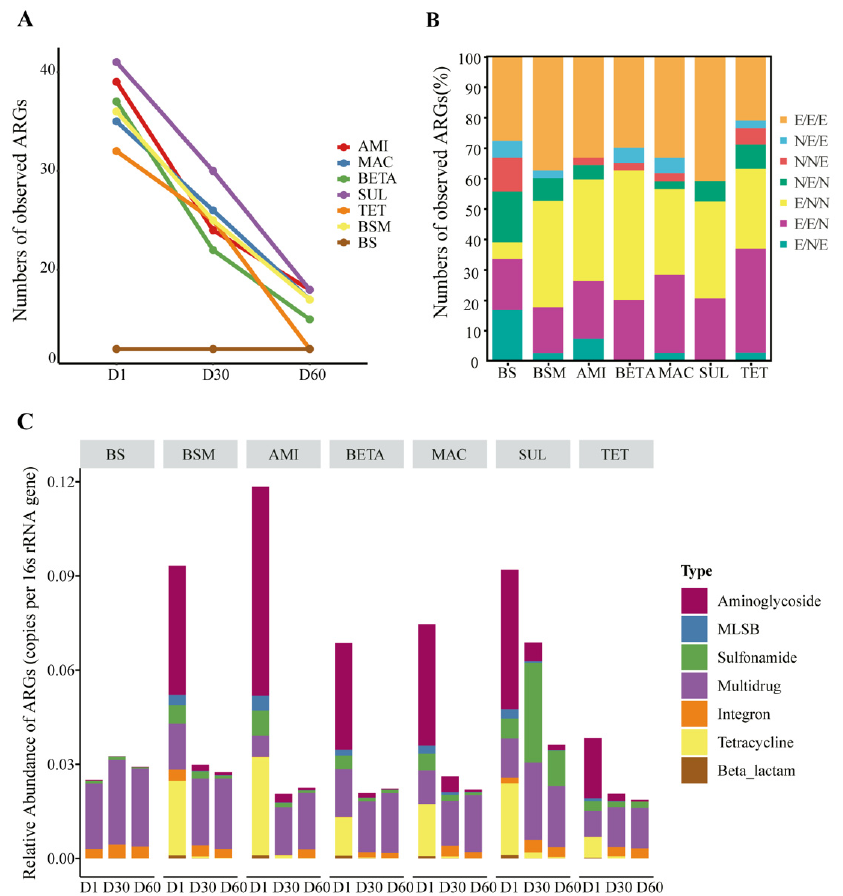
Figure 1. Temporal changes of ARG diversity and abundance. ( A ) The number of observed ARGs among different groups. ( B ) The succession of ARGs, expressed by the percentage of ARG numbers. E: exist; N: not exist; three letters orderly present the detect outcome of day 1, 30, and 60. ( C ) Relative abundance of ARGs in each sample (copies per 16s rRNA gene).